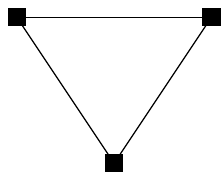
Figure 3 . The leading diagram contributing to the double trace, where the edges represent the chords connecting the different traces.